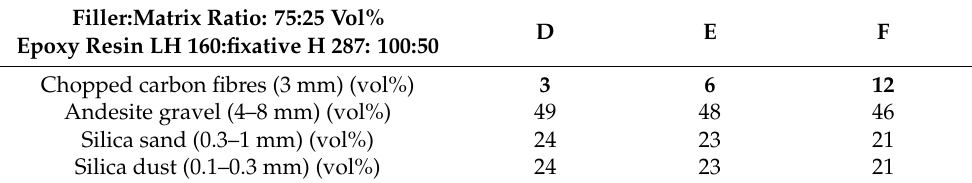
Table 2. Descriptions of Samples D–F with different short fibre volume and same fillers.